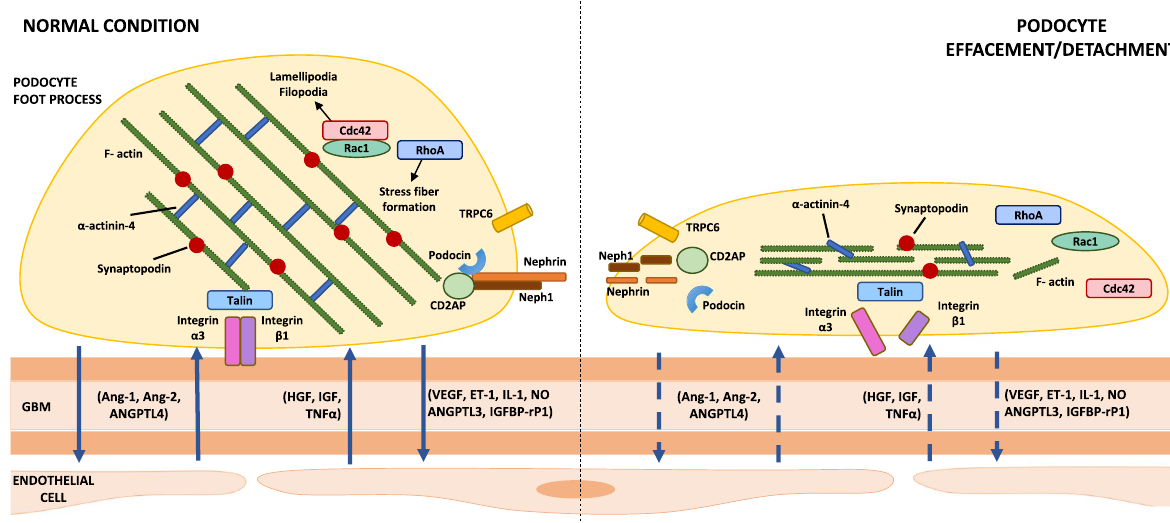
Fig. 1 Main components of the slit diaphragm and podocyte-endothelial cell cross talk in healthy versus damaged podocytes. Podocyte slit diaphragm, glomerular basement membrane (GBM), and endothelial cells are the main components of the glomerular filtration barrier. Podocyte effacement/detachment, secondary to mechanical, oxidative, and/or immunologic triggers, is characterized by loss of silt diaphragm integrity, disruption of actin cytoskeleton and focal adhesions, and interruption of the physiological podocyte-endothelial cell cross talk (dashed arrows). Abbreviations: GBM, glomerular basement membrane; Ang, angiopoietin; ANGPTL, angiopoietin-like protein; IGF, insulin-like growth factor; IGFBP-rP1, insulin-like growth factor-binding protein-related protein 1; ET-1, endothelin-1; HGF, hepatocyte growth factor; IL-1, interleukin-1; NO, nitric oxide; TNF-a, tumor necrosis factor-a; VEGF, vascular endothelial growth